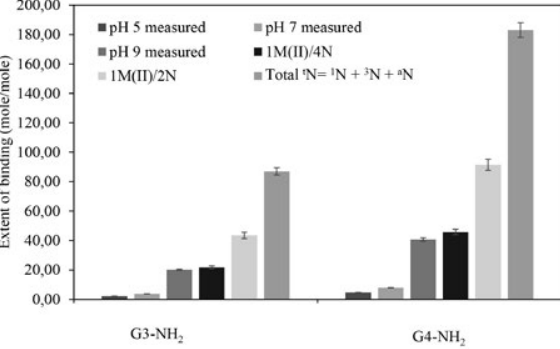
Figure 4. Maximum EOB for M(II) ions in solutions of JCPDs as a function of total number of nitrogen-containing groups ( 1 N: prima- ry amines; 3 N: tertiary amines; a N: amides; total t N = 1 N + 3 N + a